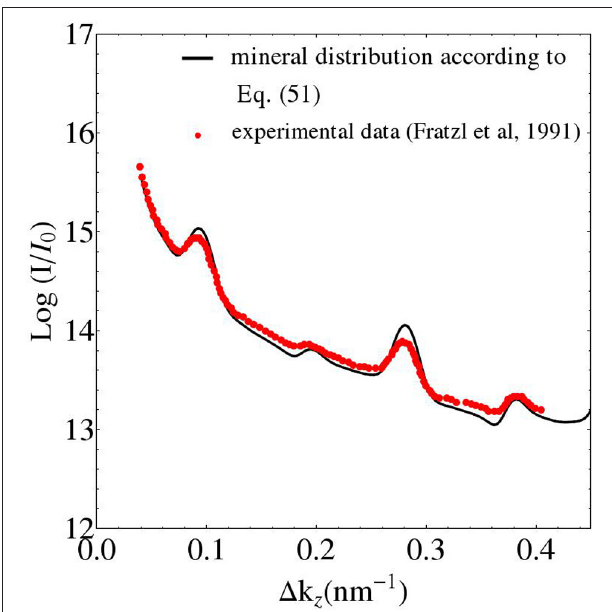
FIGURE 9 | Meridional SAXS measurements on murine bone of Fratzl et al. [ 98], indicated by red dots; in comparison to the model predictions based on identity of mineral concentrations in the extracollageneous and extrafibrillar spaces of bone ultrastructure, indicated by solid black